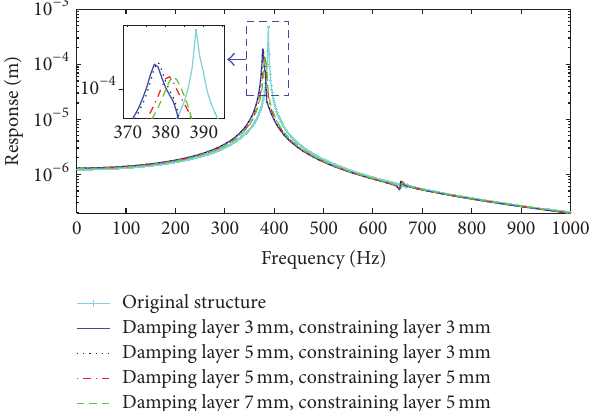
Figure 10: Response of structure with different